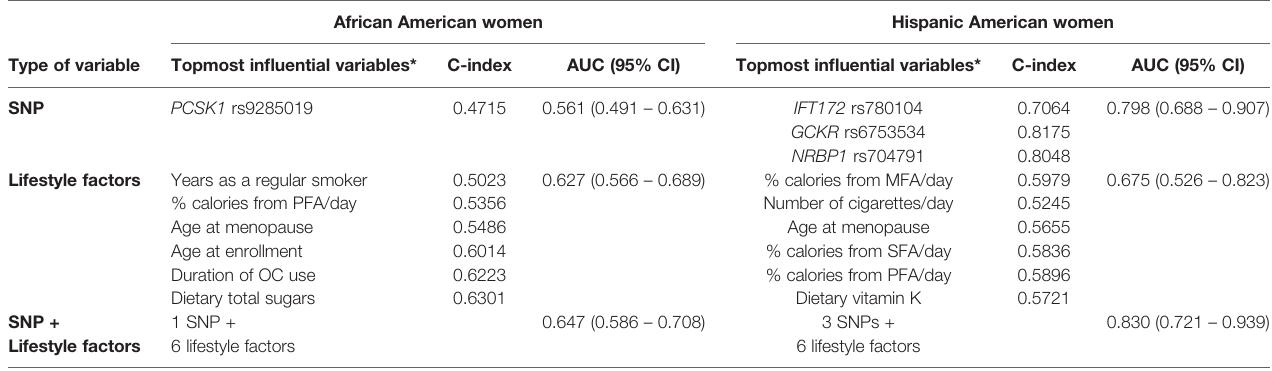
TABLE 1 | Predictive measures C-index and AUC of the topmost genetic and lifestyle factors in association with colorectal cancer risk.